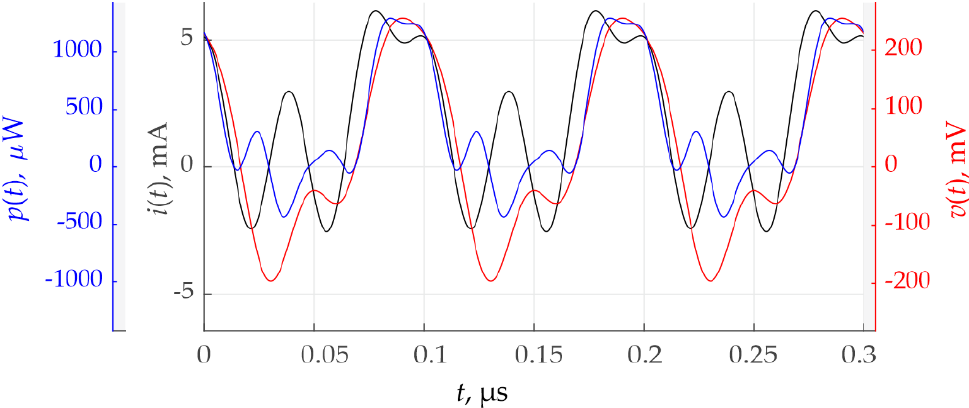
Figure 2. The current, voltage and power for the case of finite sum of harmonics current.